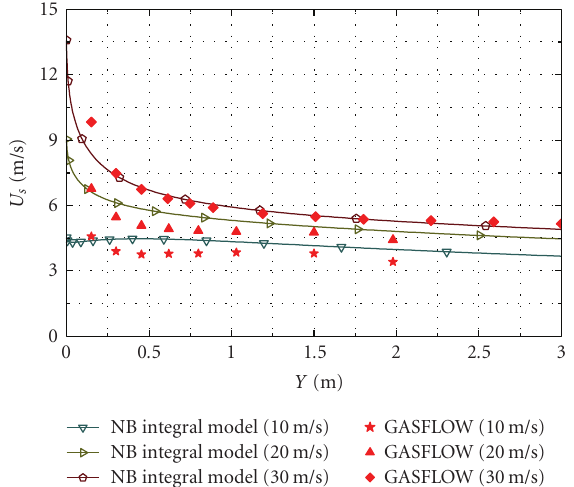
Figure 10: Velocity decay of horizontal buoyant jet with large density variations.